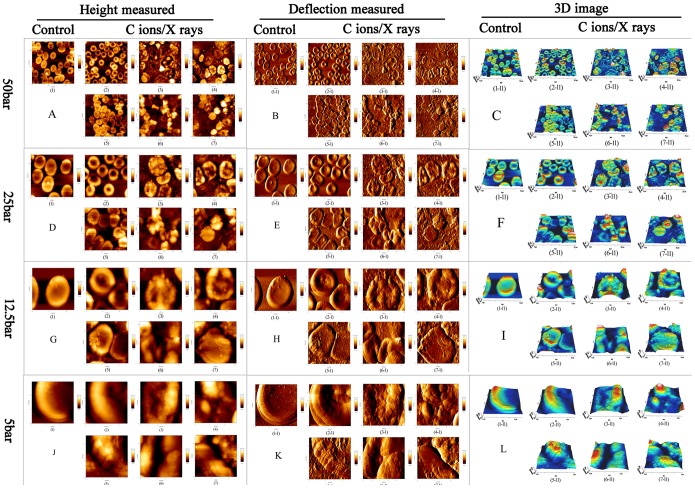
Effects of radiation on micromorphology in erythrocytes membrane.(A–L) Surface imaging of erythrocytes induced by carbon ion beams and X-rays radiation using biological type atomic force microscopy; and the graph A, B and C showed respectively for the Height measured image, Deflection image and 3D image at scan scale of 50 µm (Fast)×50 µm bar (Slow), [for A:(1) Control; (2) C ions 2Gy; (3) C ions 4Gy; (4) C ions 6Gy; (5) X-rays 4Gy; (6) X-rays 6Gy; (7) X-rays 12Gy; for B: (1–1) Control; (2–1) C ions 2Gy; (3–1) C ions 4Gy; (4–1) C ions 6Gy; (5–1) X-rays 4Gy; (6–1) X-rays 6Gy; (7–1) X-rays 12Gy; for C: (1–11) Control; (2–11) C ions 2Gy; (3–11) C ions 4Gy; (4–11) C ions 6Gy; (5–11) X-rays 4Gy; (6–11) X-rays 6Gy; (7–11) X-rays 12Gy]. But the graph D–F showed respectively for the Height measured image, Deflection image and 3D image at scan scale of 25 µm (Fast) ×25 µm bar (Slow); the graph G–I showed respectively for the Height measured image, Deflection image and 3D image at scan scale of 12.5 µm (Fast) ×12.5 µm bar (Slow); the graph J–L showed respectively for the Height measured image, Deflection image and 3D image at scan scale of 5 µm (Fast) × 5 µm bar (Slow). In addition, for a smaller scan scale was the same grouping as 50 µm (Fast) × 50 µm bar (Slow) bar. Here, the schematic showed different doses and type radiation for the influence of micromorphology of erythrocytes, and this fine change was captured by AFM.